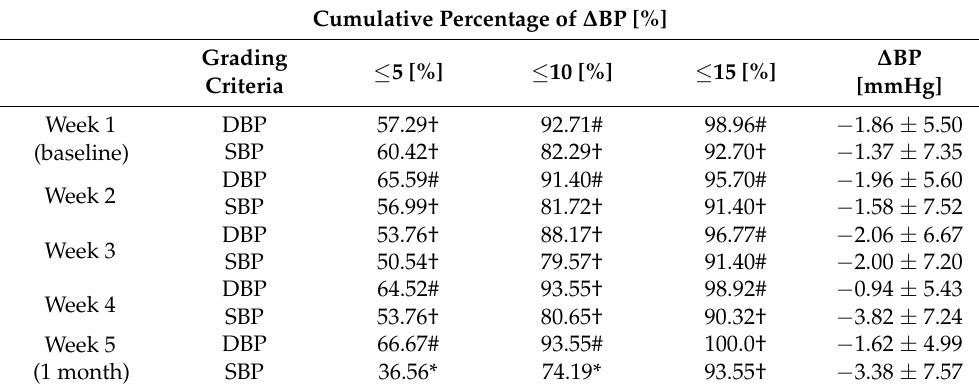
Table 2. Performance evaluation for ∆ BP and the cumulative percentage of ∆ BP over a 1-month period (5 weeks).